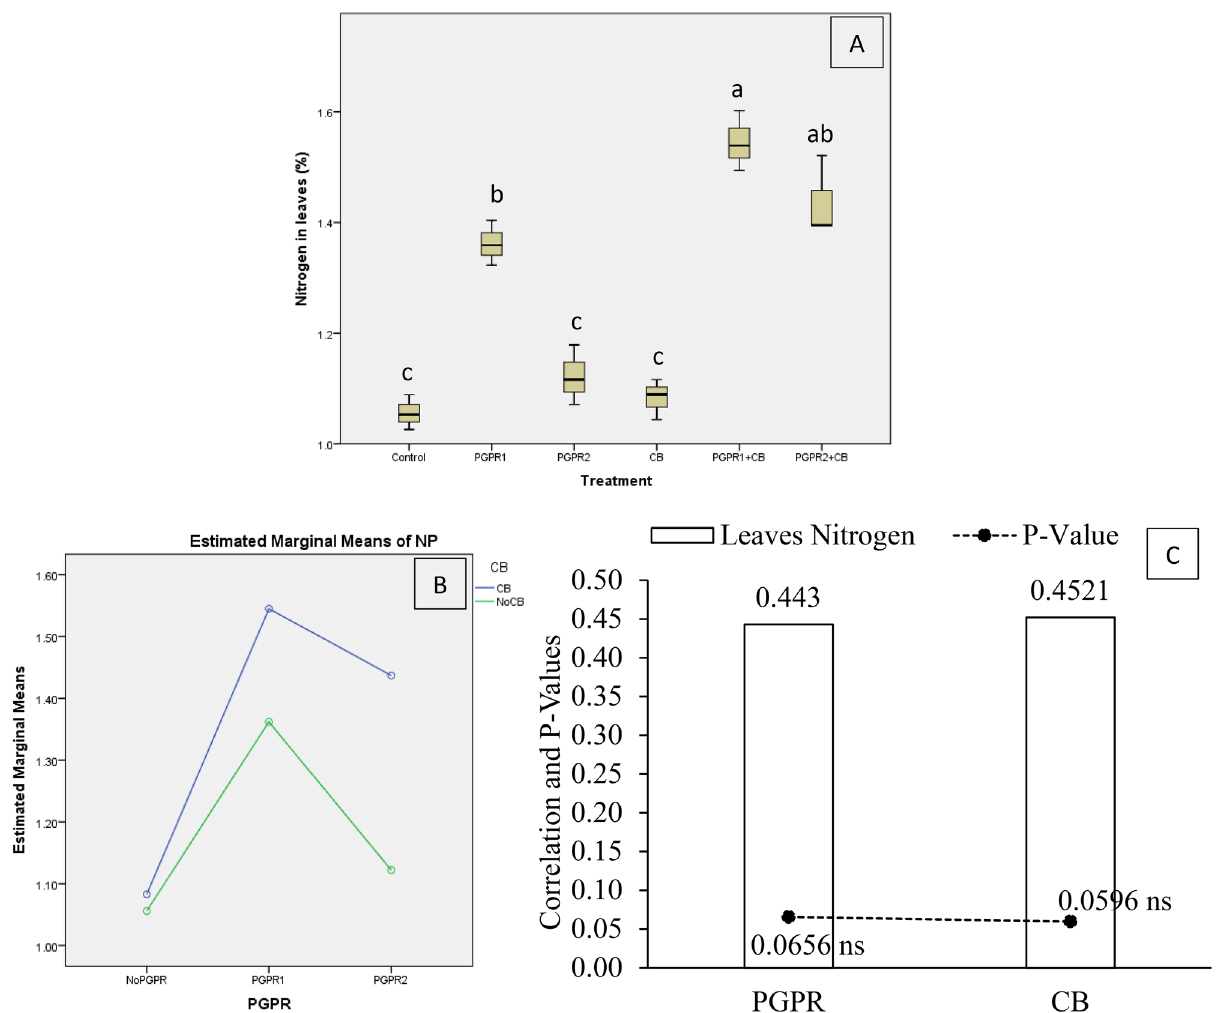
Figure 12. Effect of treatments on mint plants leaves nitrogen concentration (NP). Values are the average of three replicates ( A ). Different letters showed significant differences (Tukey’s test; p ≤ 0.05). Interaction graph of PGPR and CB for NP ( B ). Correlation graph of PGPR and CB for NP ( C